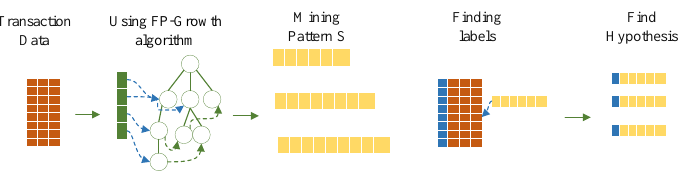
Figure 2. Pattern mining